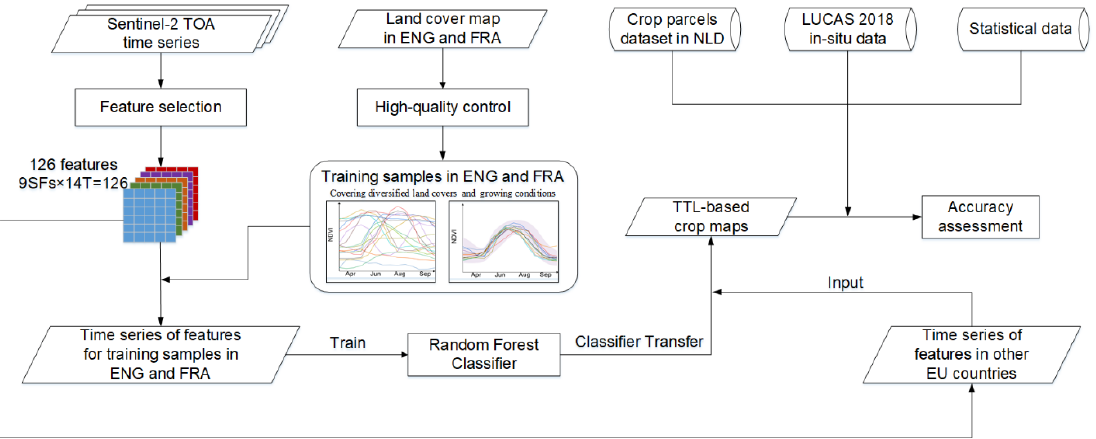
Figure 2. Flow chart of the methodology for the large-area crop mapping using transductive transfer learning approach.